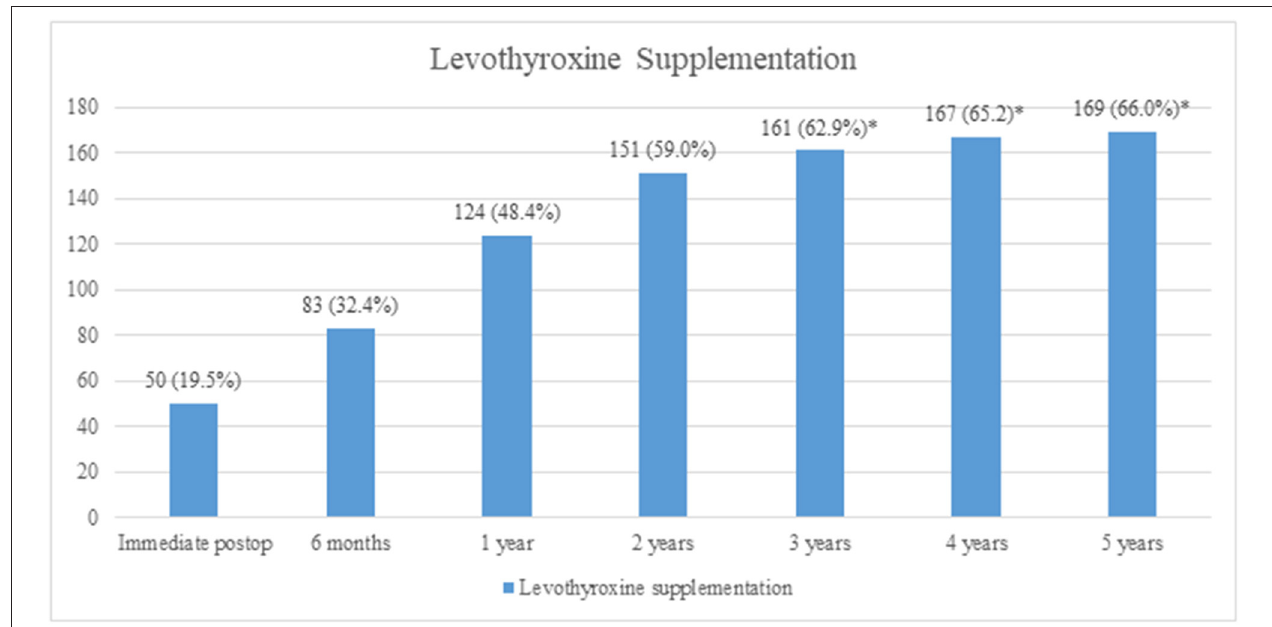
FIGURE 1 | Incidence of hypothyroidism and levothyroxine supplementation. A significant increase in incidence was observed until 3 years ( p < 0.001), whereas after 3 years, there was no significant increase (* p > 0.05, analyzed by the McNemar’s test).